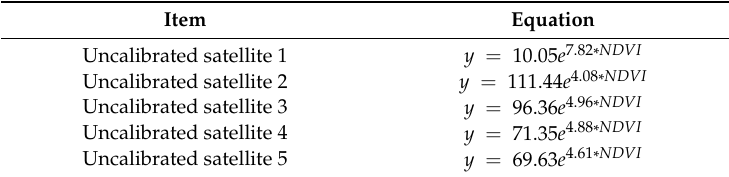
NDVI = normalized di ff erence vegetation index; Uncalibrated satellite 1 to 4 = NDVI to biomass calibration equations published for Australia by MLA [25]; Uncalibrated satellite 5 = NDVI to biomass calibration equation published for the United States by Insua et al.